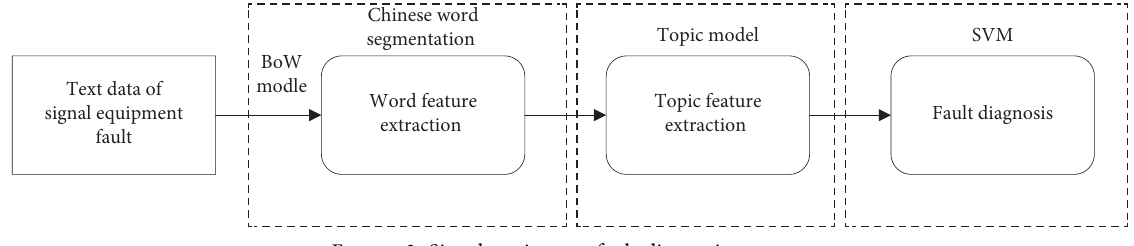
Figure 3: Signal equipment fault diagnosis